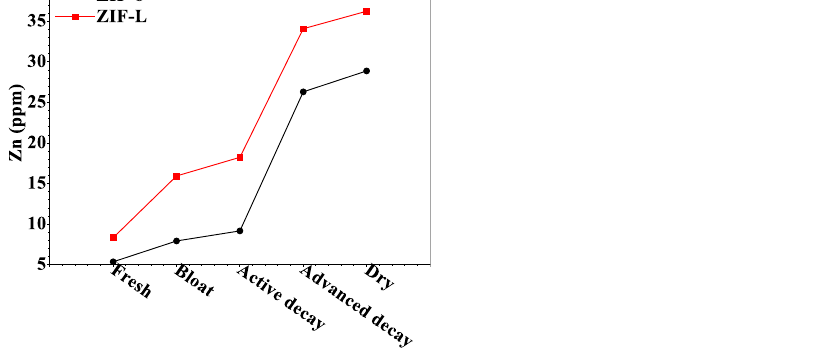
Figure 4. Zinc concentration in larvae collected from the carrions treated with ZIF-8 and ZIF-L.